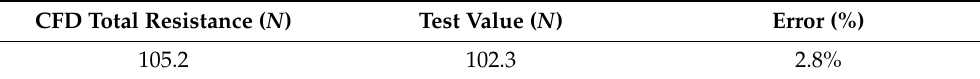
Table 2. Comparison between the total hull resistance calculated by CFD and the test value.